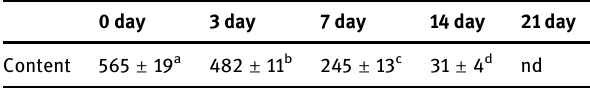
Table 1: Pesticide residues in jujube